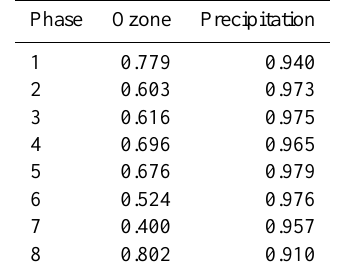
Table 2. Longitude–altitude (surface to 100hPa) spatial correla- tion coefficients between modeled and measured ozone anoma- lies and longitudinal correlation coefficients between modeled and measured precipitation anomalies, correlated for each phase of the MJO between CAM-chem and TES tropospheric ozone column (936 points) and CAM-chem and TRMM precipitation (144 points). Fields are averaged from 10 ◦ S to 10 ◦ N. All correlation coefficients pass the Student’s t test at 95% confidence